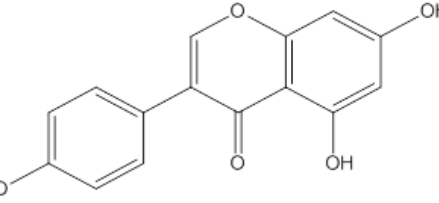
Figure 1. The chemical structural formula for Gen.